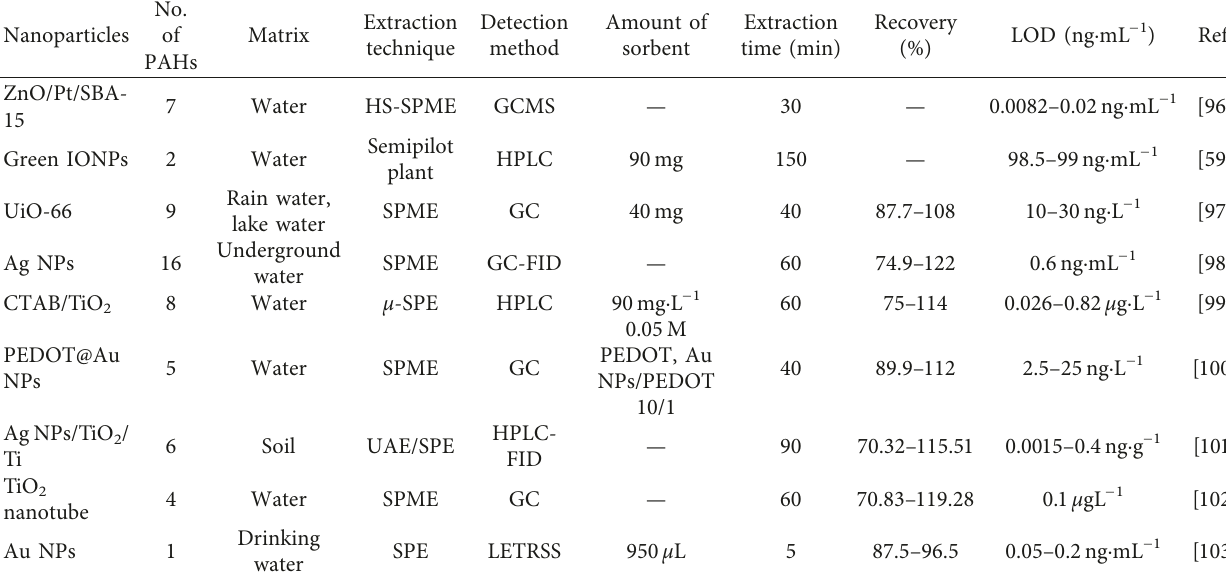
Table 9: Some metal and metal oxide NPs used in the extraction of PAHs.